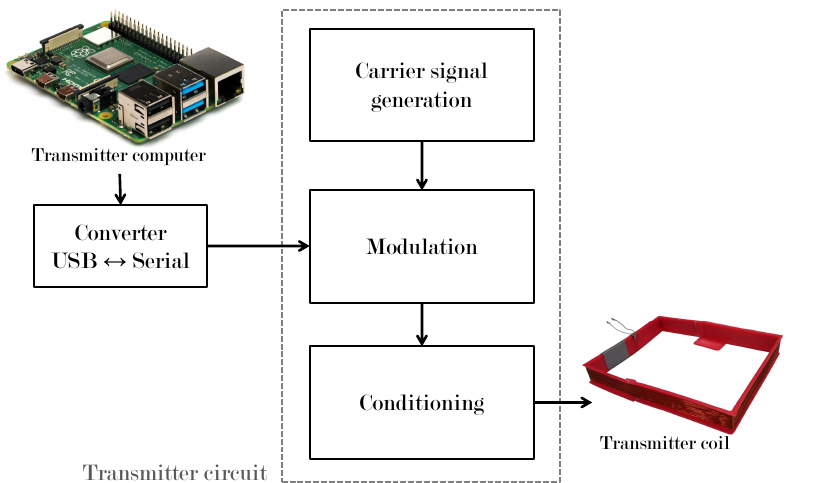
Figure 5. Transmitter